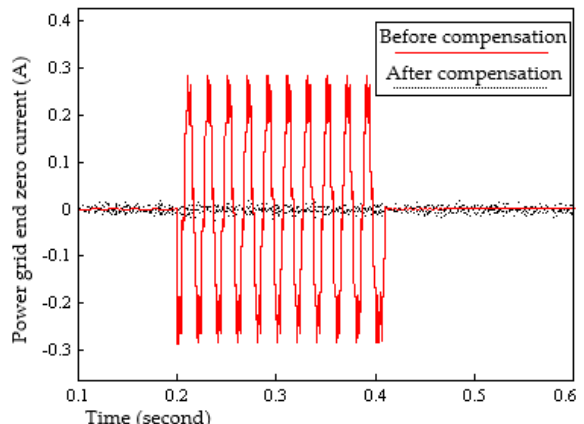
Figure 17. The power grid-end neutral current before and after compensation.